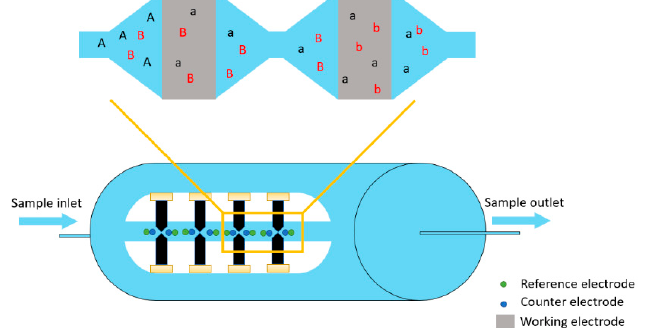
Figure 1. The inlet of the CoulArray detector. A and B represent compounds being eluted in the CoulArray detector, a and b are compounds who have lost electrons after being oxidized by passing through porous working electrodes set at different